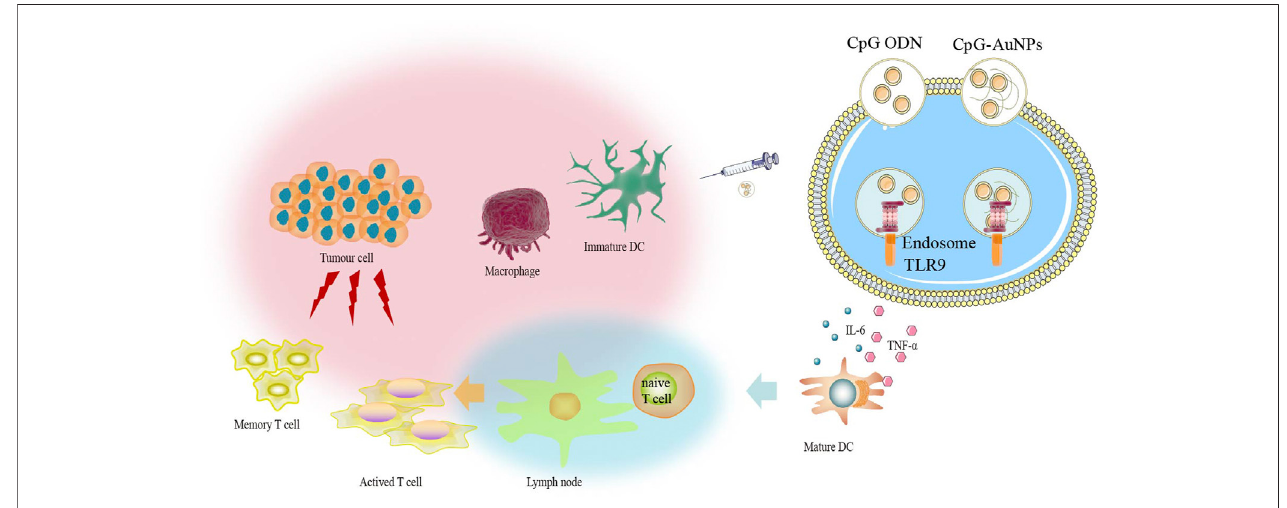
FIGURE 3 | The CpG delivery system based on gold nanoparticles (AuNPs) can induce strong immune response even at low dose of CpG via TLR9 interaction.